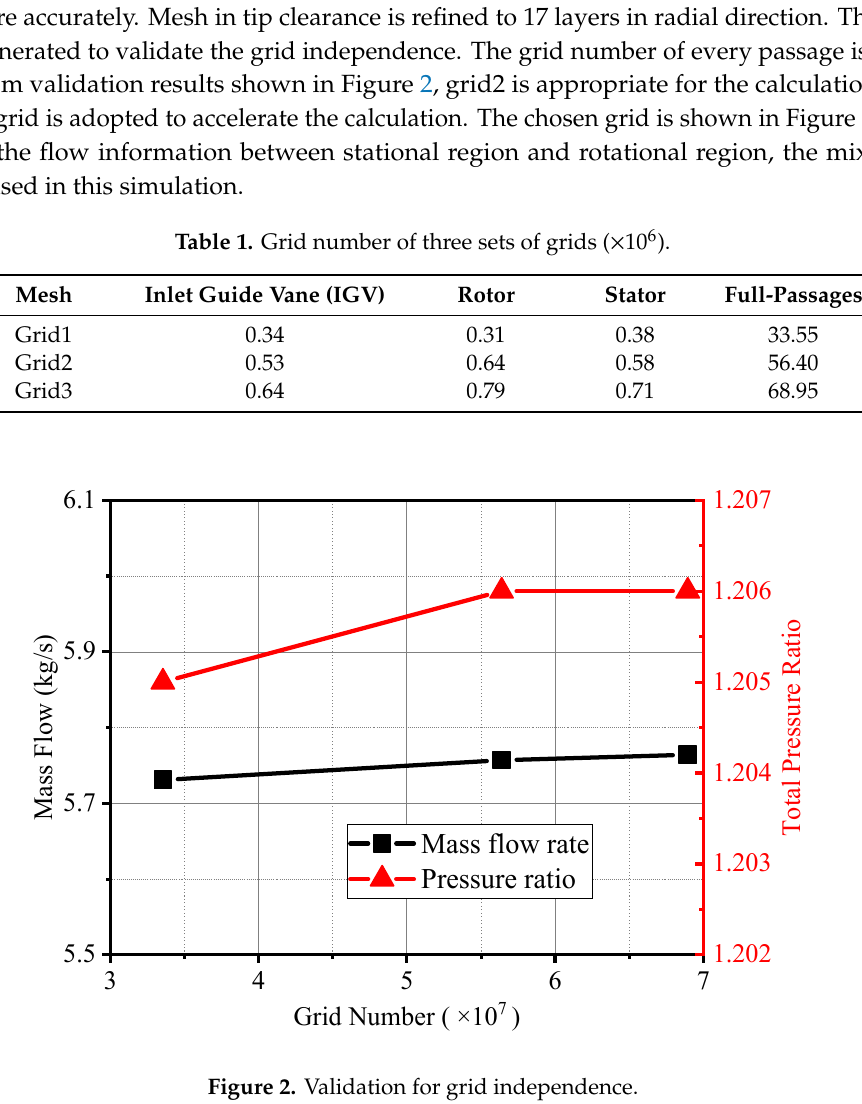
Figure 2. Validation for grid independence.